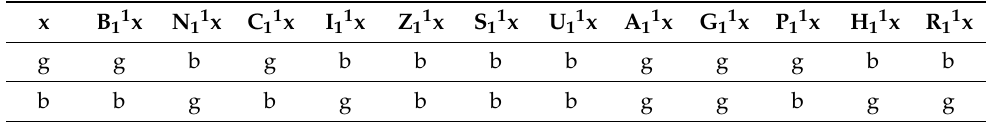
Table 1. Definition of the functions determined by one evaluation argument.